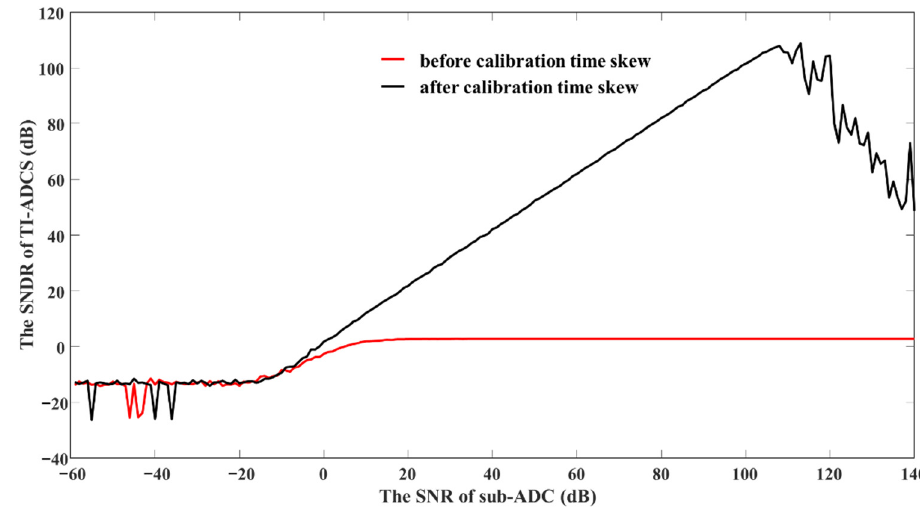
Figure 11. The performance of the proposed technique with different SNR of the input signal.